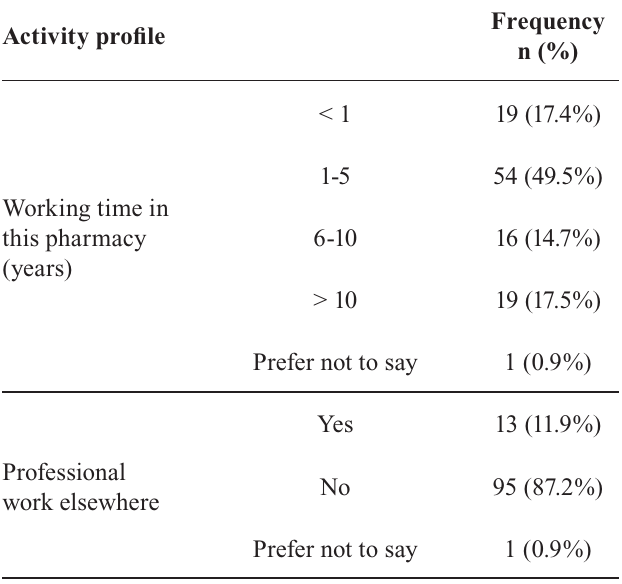
TABLE III - Activities performed by pharmacists in charge of community pharmacies in the metropolitan area of Belo Horizonte (n = 109;